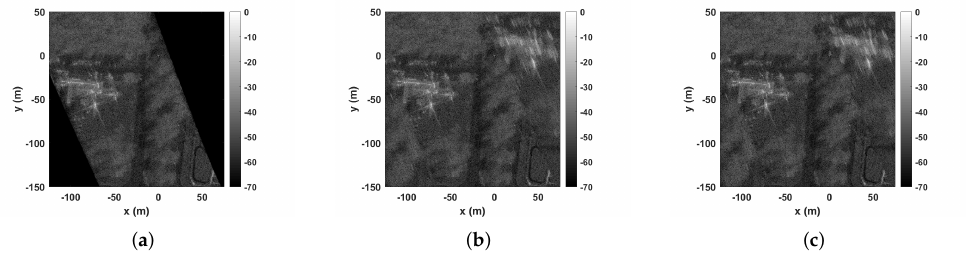
Figure 10. Images from the GMTI dataset generated using the backprojection algorithm, matched filter algorithm, and fast-factorized backprojection algorithm. ( a ) GMTI dataset image generated using the backprojection algorithm. ( b ) GMTI dataset image generated using the matched-filter algorithm. ( c ) GMTI dataset image generated using the fast-factorized backprojection algorithm.